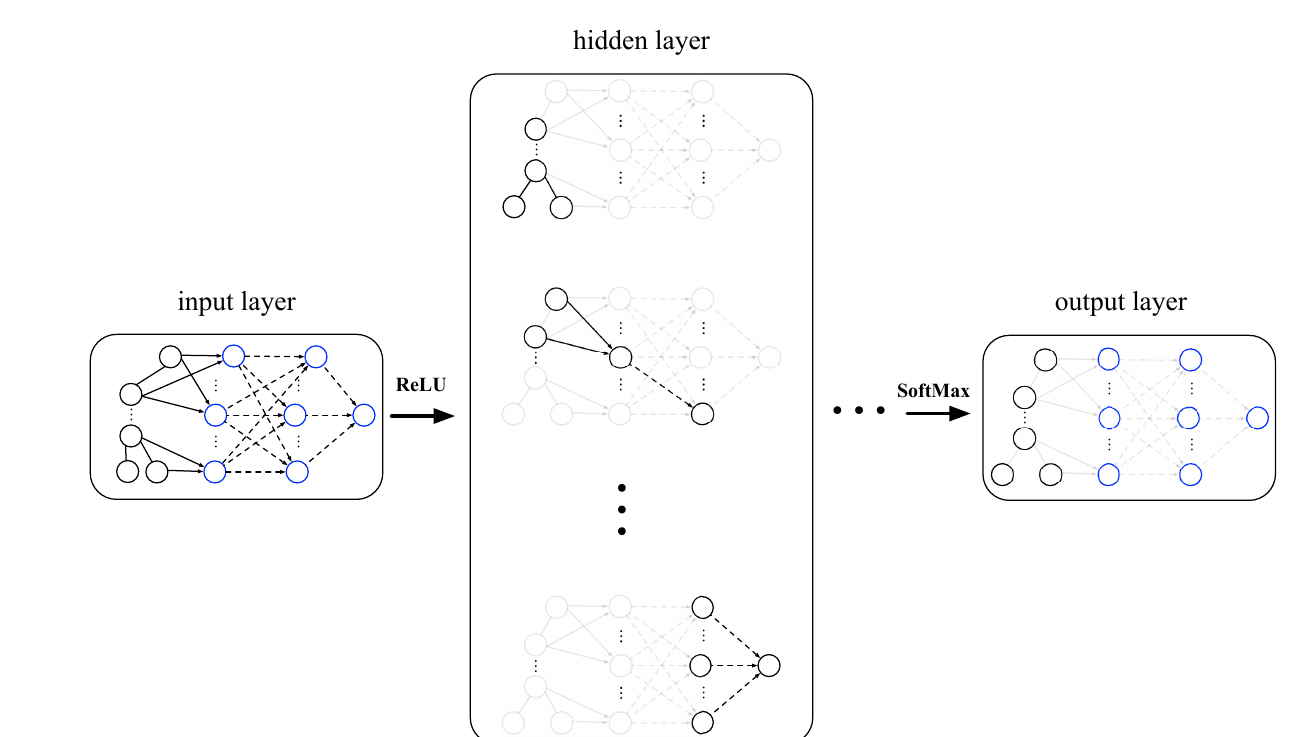
Figure 2. Fault propagation scheme based on graph neural